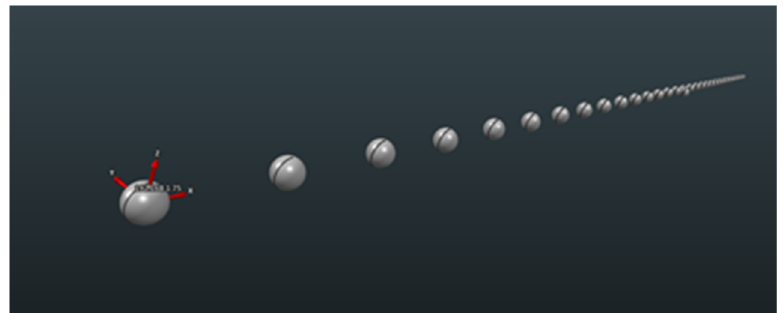
Figure 5. System deviations: ( a ) software output and ( b ) geometrical interpretation of the result.